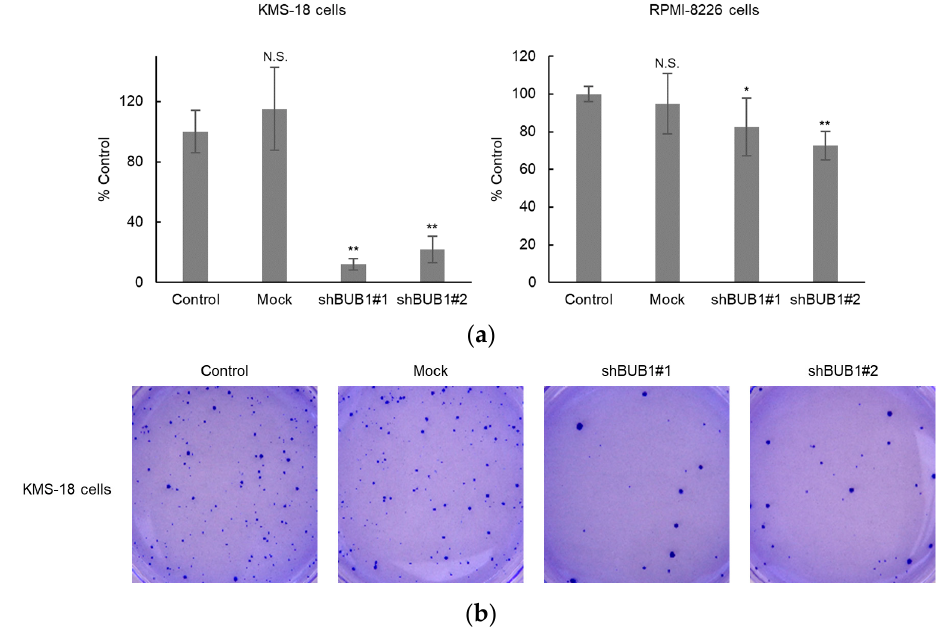
Figure 6. BUB1 knockdown impaired colony-forming capacity in KMS-18 and RPMI-8226 cells. ( a , b ) Control, mock-treated, or BUB1-reduced KMS-18 (left) and RPMI-8226 (right) cells were subjected to a colony-forming assay. Triplicate assays were performed in two independent experiments. Data are shown as means ± SD. * p < 0.05, ** p < 0.01 vs. control cells in a two-tailed t -test. N.S.: not significant.